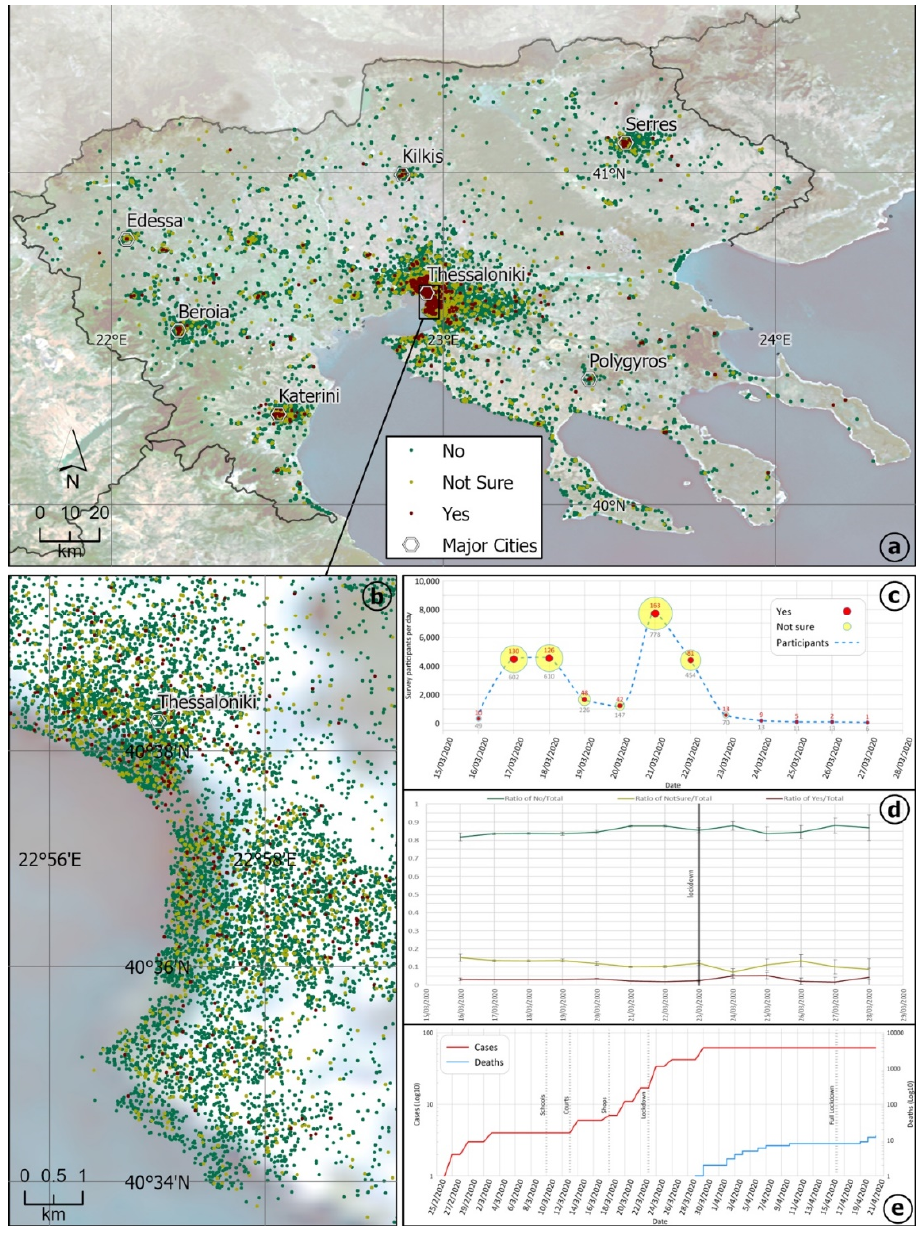
Figure 6. Spatial distribution of survey entries for ( a ) the Region of Central Macedonia and ( b ) the greater area of Thessaloniki. Temporal evolution for the Region of Central Macedonia of ( c ) the number of participants per day with the number of Yes and Not Sure annotated; ( d ) ratios of the three different answers per day (left axis), compared to the confirmed cases (number/day; right axis); ( e ) the confirmed cases and deaths per day in Central Macedonia since the recording of the first confirmed case in Greece. Critical restriction of activities is also indicated with vertical solid or dashed lines.